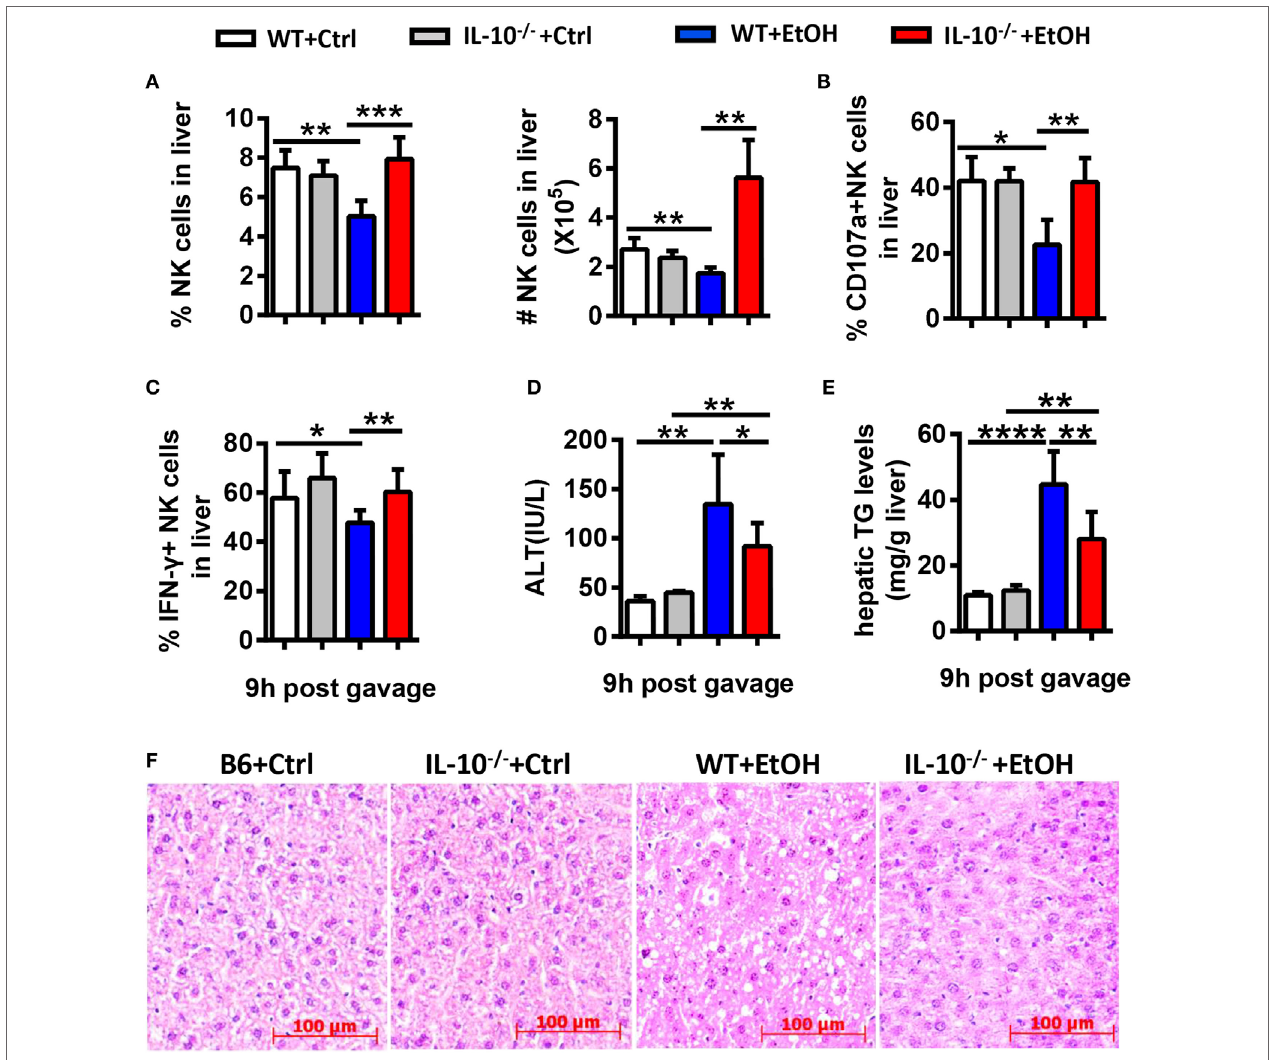
FigUre 10 | Interleukin-10 (IL-10) deficiency promoted natural killer (NK) cell accumulation and activation and alleviated alcoholic hepatosteatosis. Wild-type or IL-10 − / − mice were fed control or ethanol diets for 10 days, followed by gavage, and the mice were euthanized 9 h after gavage. (a–c) Liver mononuclear cells were isolated. (a) The frequency and numbers of CD3 − NK1.1 + NK cells among all leukocytes in the liver were analyzed by flow cytometry. (B,c) Statistical analysis of the percentages of (B) CD107a + (with PMA stimulation) and (c) interferon- γ + NK cells (with PMA stimulation). (D–F) Liver injury and steatosis were evaluated based on (D) serum alanine aminotransferase and (e) hepatic triglyceride levels and (F) liver tissue hematoxylin and eosin staining (original magnification, 200 × ). The data are representative of two independent experiments and are shown as the mean ± SEM ( n = 4–10). * P < 0.05; ** P < 0.01; *** P < 0.005; **** P <